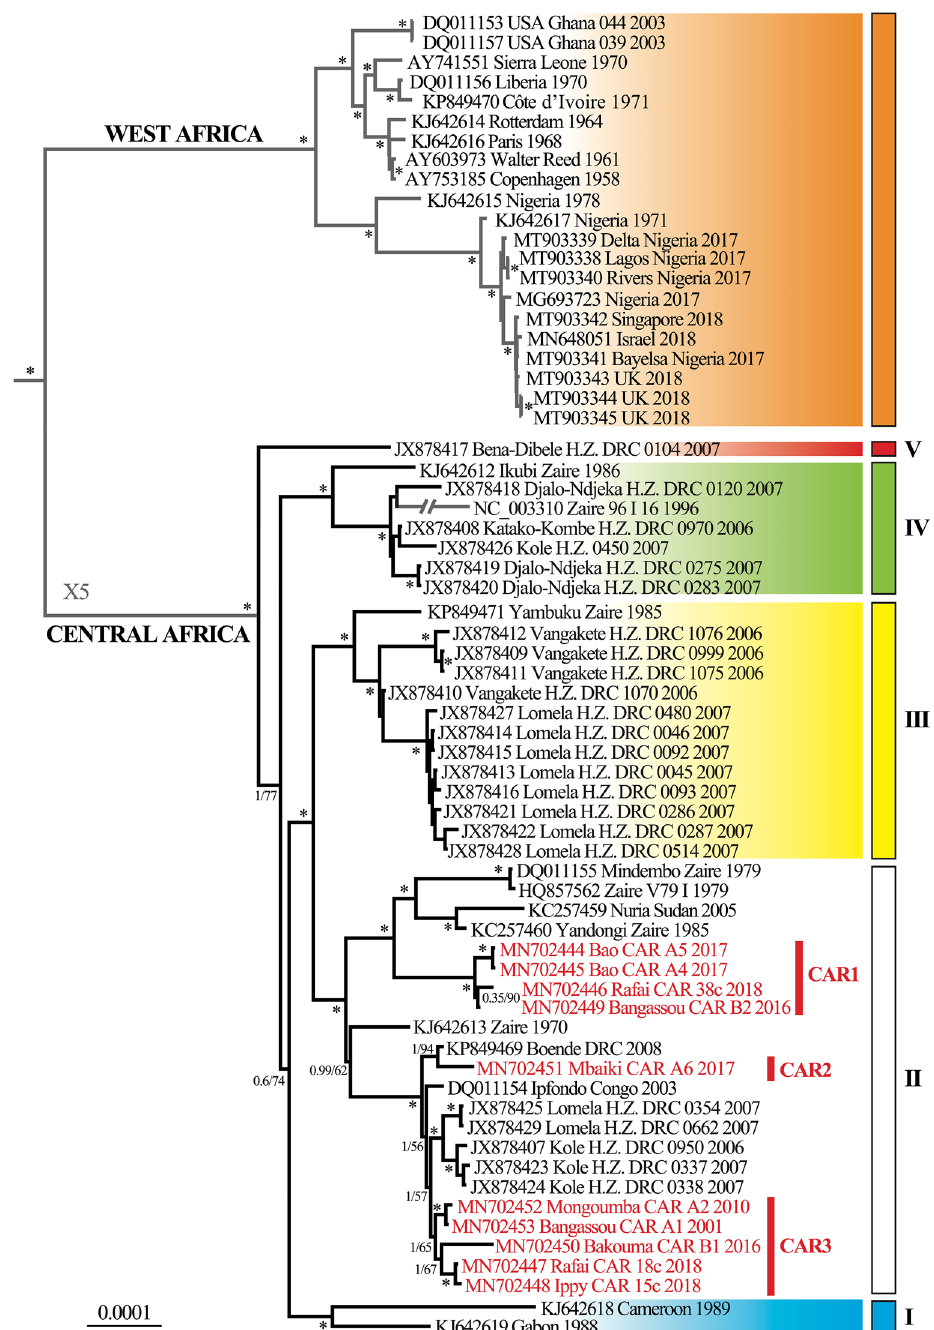
Figure 2. Phylogeny of monkeypox viruses (MPXV) based on complete genomes. The Bayesian tree was reconstructed using the GTR+G model. The two sequences used as outgroup are not shown. For each MPXV sequence, we indicated the accession number in GenBank, the geographic locality, the country, the code, and the year. The 10 MPXV genomes specially sequenced for this study are written in red. Branches with an asterisk were supported by maximal Bayesian posterior probability (PP = 1) and ML bootstrap proportions ≥ 95. The main clades were highlighted with different colours: West African clade (orange), Central African group I (blue), II (white), III (yellow), IV (green) and V (pink). For convenience, the size of longest branches shown in grey was reduced by